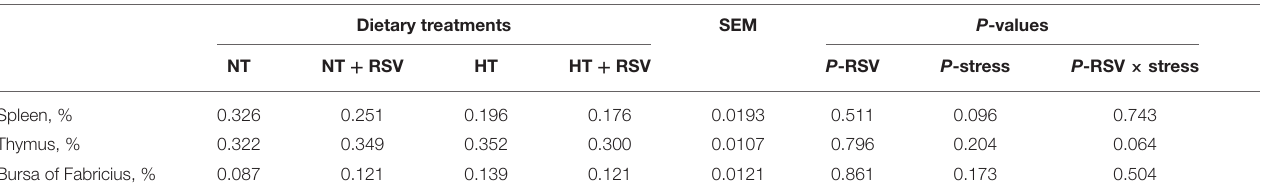
TABLE 6 | Effect of heat stress and RSV on organ index of 42-day-old broilers (d 14 of heat treatment). Dietary treatments SEM P -values NT NT + RSV